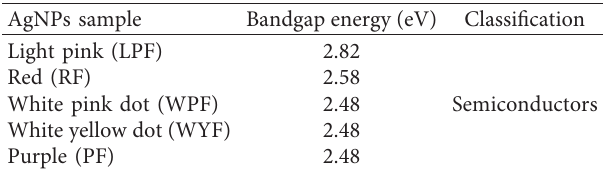
Table 2: Classification of the synthesized AgNPs based on bandgap